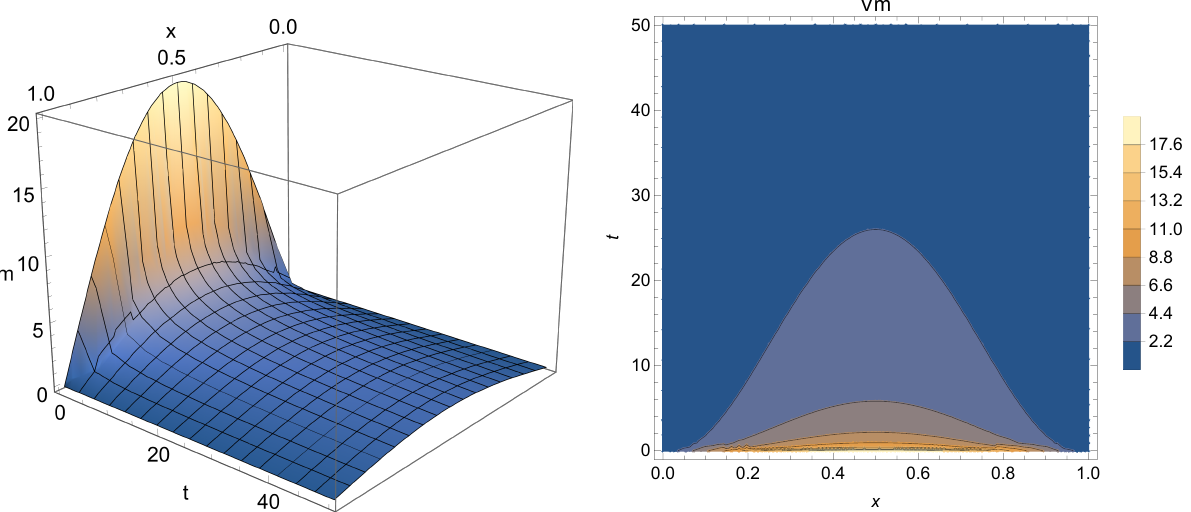
Figure 3. One-dimensional homogeneous solution describing the potential plateau after depolariza- tion: Equation (10) with α =